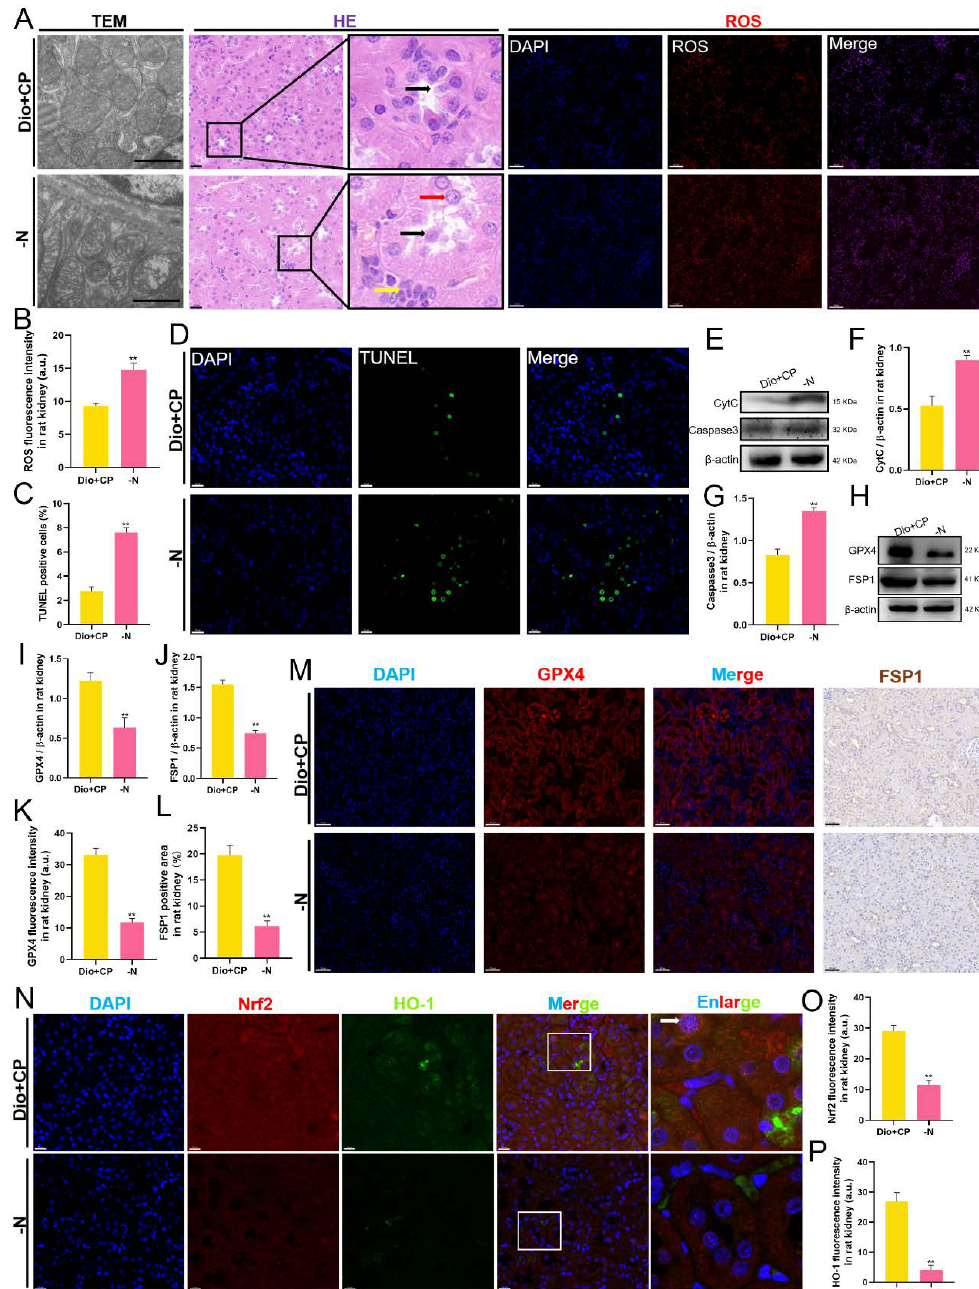
Figure 6. The protective effect of dioscin on rat kidneys is attenuated after Nrf2 inhibition. ( A ) Representative images of transmission electron microscope (scale bar = 1 μm), H&E staining (scale bar = 20 μm), and ROS staining (scale bar = 50 μm) in rat kidneys (n = 5). ( B ) Quantification of ROS staining in rat kidneys. ( C , D ) Representative images and quantification of TUNEL staining (scale bar = 20 μm) in rat kidneys (n = 5). ( E – G ) The protein levels of CytC and Caspase3 in rat kidneys (n = 3). ( H – J ) The protein levels of GPX4 and FSP1 in rat kidneys (n = 3). ( K – M ) Representative images and quantification of GPX4 immunofluorescence (scale bar = 50 μm) and FSP1 immunohistochemistry (scale bar = 50 μm) in rat kidneys (n = 5). ( N – P ) Representative images and quantification of Nrf2 and HO-1 immunofluorescence (scale bar = 20 μm) in rat kidneys (n = 5). C, control group; Dio, dioscin group; CP, cisplatin group; Dio + CP, dioscin + cisplatin group. ** p <0.01 represents extremely significant difference. Results are presented as Mean ± SD. Statistical significance was obtained via an unpaired Student’s t -test.